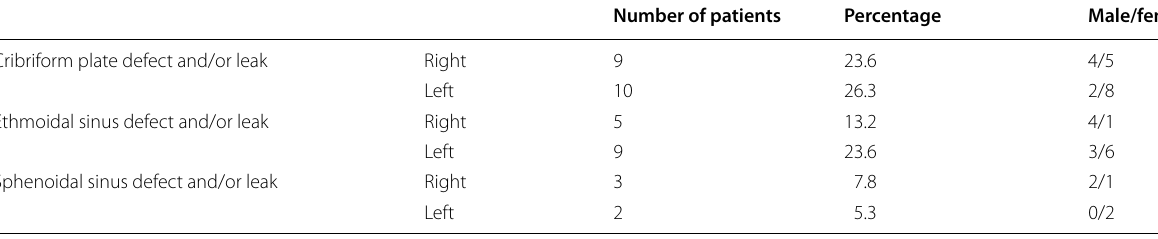
Number of patients